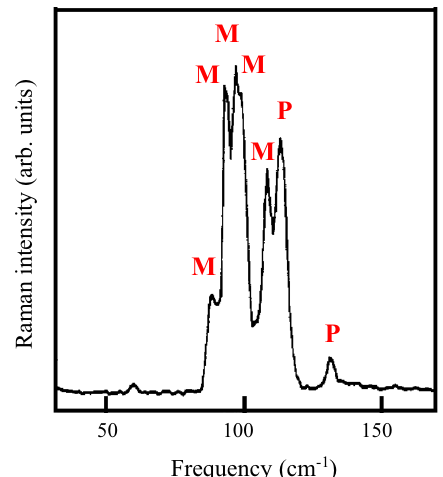
Figure 2. The low-frequency Raman spectrum of RbCoC1 3 recorded with a spectral resolution of 2.2 cm −1 at ~ 11 K in X(ZX)Y polarization. The Raman peaks labelled M are magnetic excitations that have been evaluated elsewhere 6 , and those labelled P are the phonons of interest